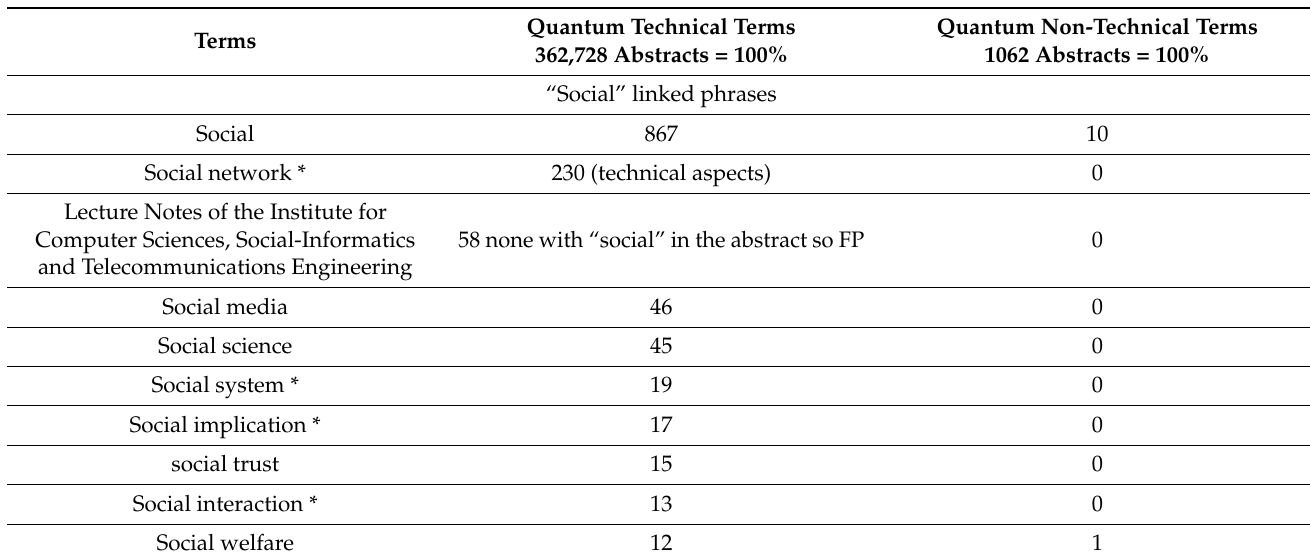
Table 11. Presence of “social” or “societal” linked phrases in the academic literature focusing on quantum technologies including the ones already mentioned within other tables such as Table